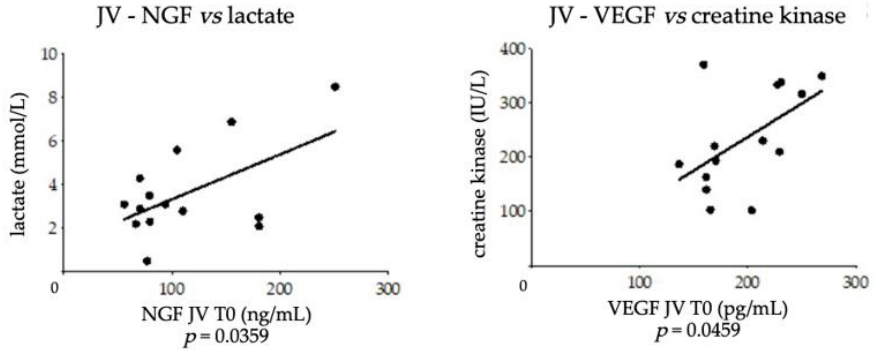
Figure 3. Significant correlations found between NGF and VEGF levels in plasma samples obtained from foal’s jugular vein and hematobiochemical parameters at T0. Statistical analysis: parametric Pearson correlation (JV–NGF vs. lactate and JV–VEGF vs. creatine kinase).